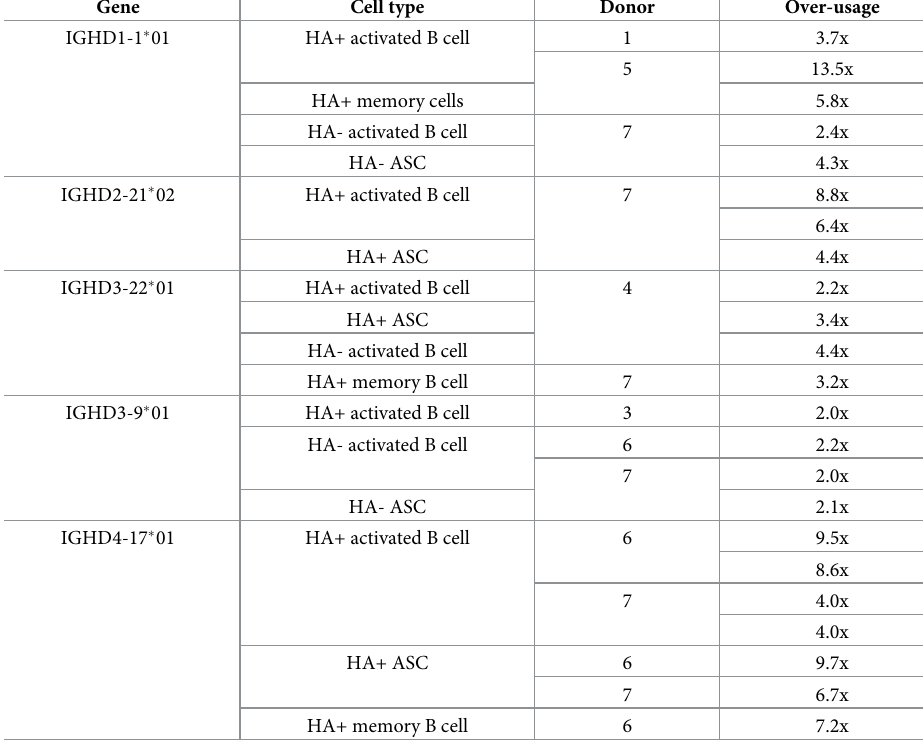
Table 7. Overused genes in Flu Vaccination datasets. Since the number of datasets in PRJNA324093 is much greater than in other projects, only genes that are overused in at least three different datasets are shown. The over-usage of a gene in a dataset is also shown. For example, the usage of IGHD1-1 � 01 in HA+ activated B cells for donor 1 is 3.7 times the maximum usage in all Healthy Human datasets. Gene Cell type